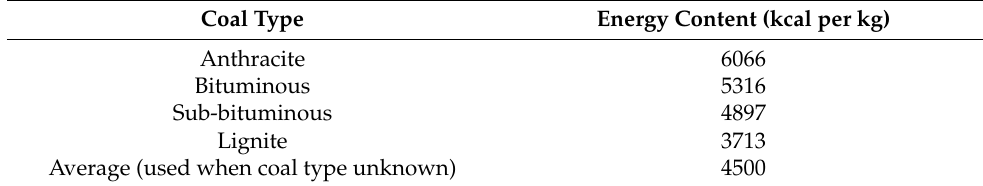
Table A7. Coal energy content assumptions. Source: Carbon Tracker Initiative.